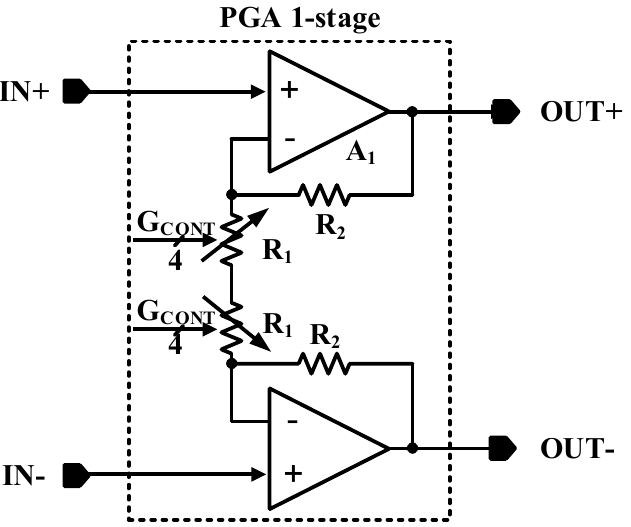
Figure 7. The schematic of the PGAs of the system.